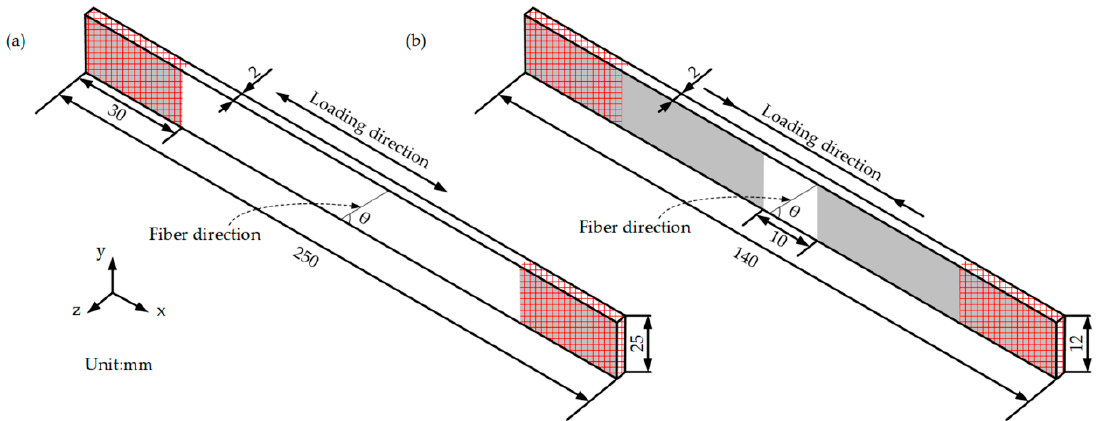
Figure 3. Finite element models: ( a ) Off-axis tension; ( b ) Off-axis compression.